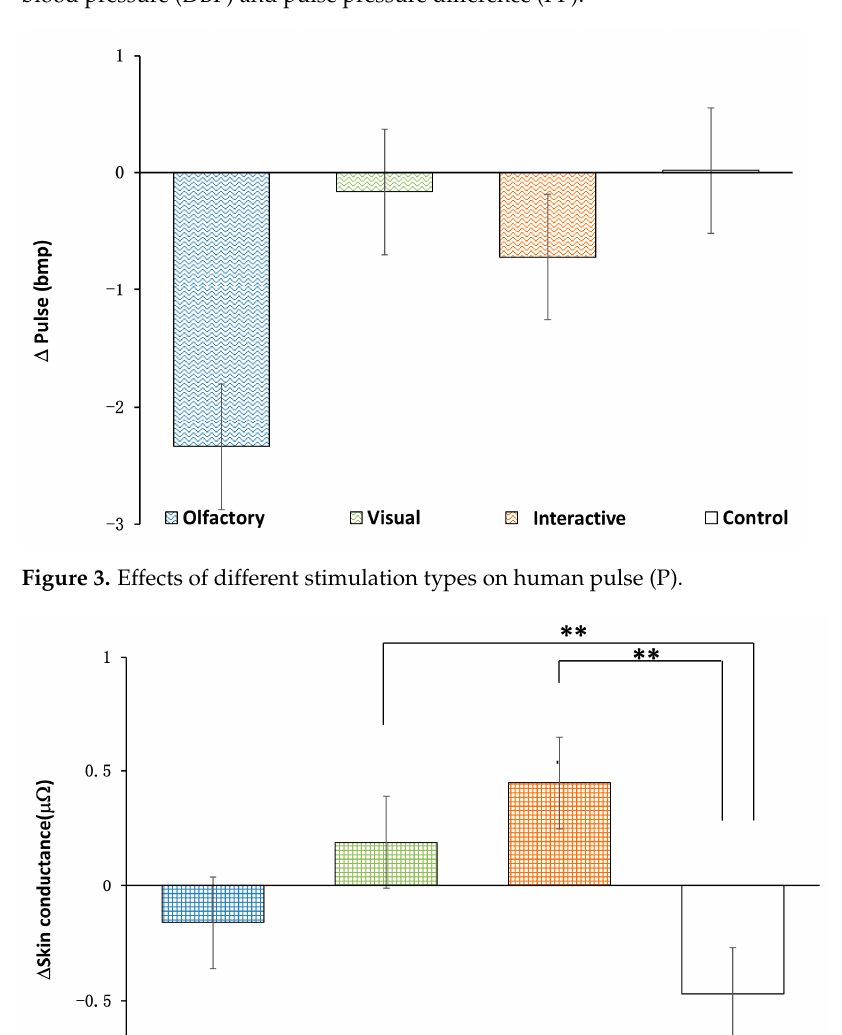
Figure 2. Effects of different stimulation types on human systolic blood pressure (SBP), diastolic blood pressure (DBP) and pulse pressure difference (PP).